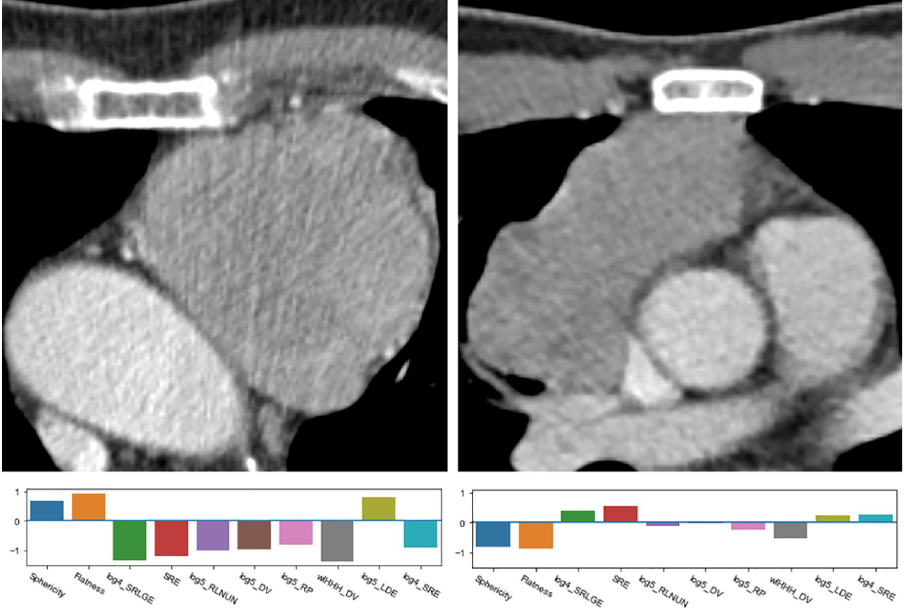
Fig 6. Comparison of a low-risk TET (LRT, left image) and high-risk TET (HRT, right image) with corresponding radiomic fingerprints. Both tumors have been captured in early stages. DV: Dependence variance. LoG n : Laplacian of Gaussian filter with σ = n. RLNUN: Run length non-uniformity. SRLGE: Short run low gray emphasis. SRE: Short run emphasis. wlHHH: Wavelet filter with high-pass filters (H) in every spatial direction. LDE: Large dependence